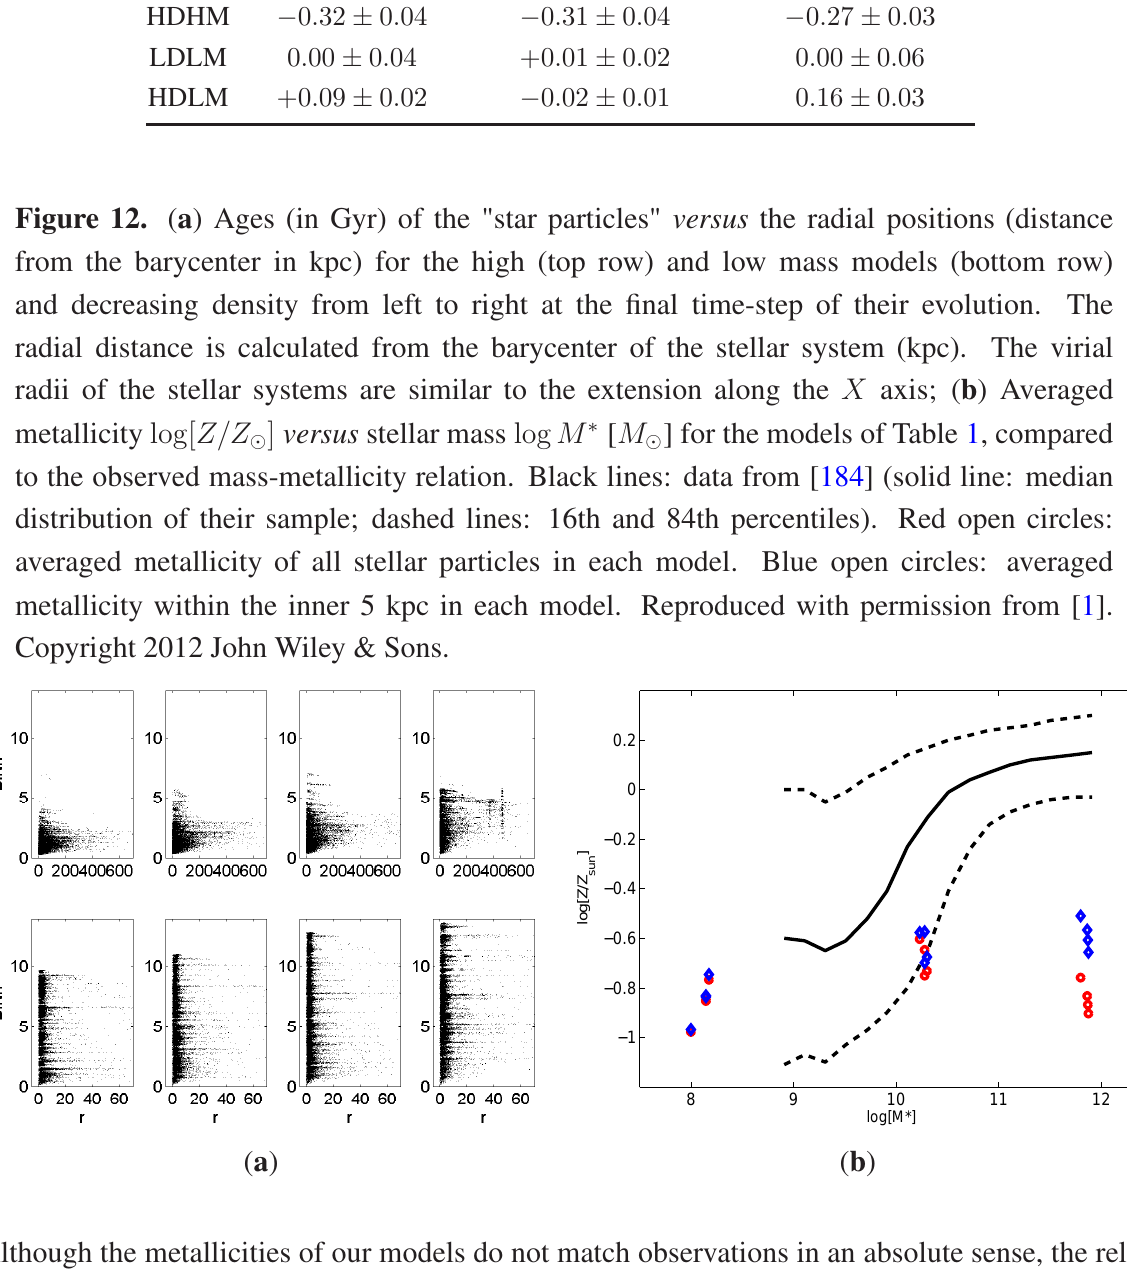
to 1 R . eff eff ∇ Z